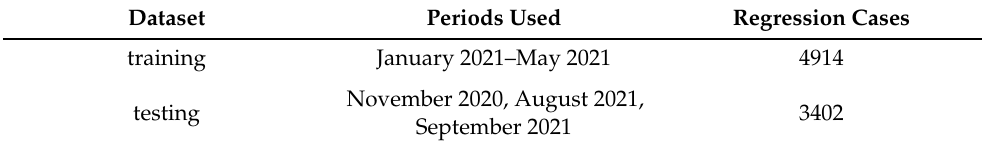
Table 3. Temporal arrangement and size of datasets used for supervised machine